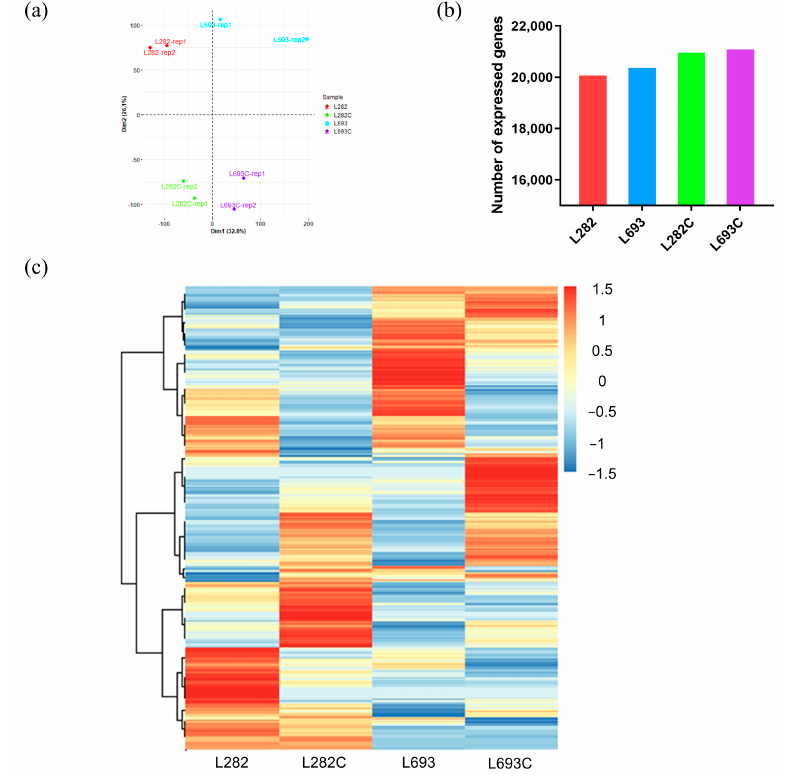
Figure 2. Transcriptome analysis of L282 and L693 seeds germinated at normal and low temperatures. ( a ) Principal component analysis of the gene expression profiles in L282 and L693 seeds germinated under normal (L282 and L693) and cold (L282C and L693C) conditions; ( b ) the number of expressed genes identified from L282, L693, L282C, and L693C; ( c ) heatmap clustering of the expressed genes. Red and blue indicate high and low abundances, respectively, according to the normalized FPKM.